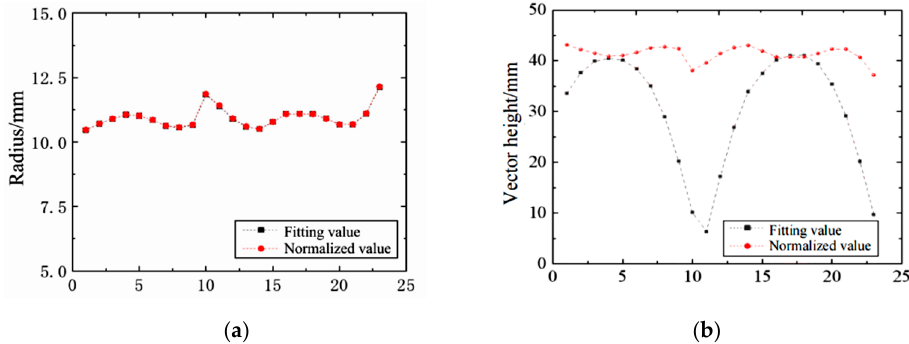
Figure 10. Comparison of processing results of off-axis detection method. ( a ) Radius values at 4° declination. ( b ) Value of vector height at 4° declination angle.